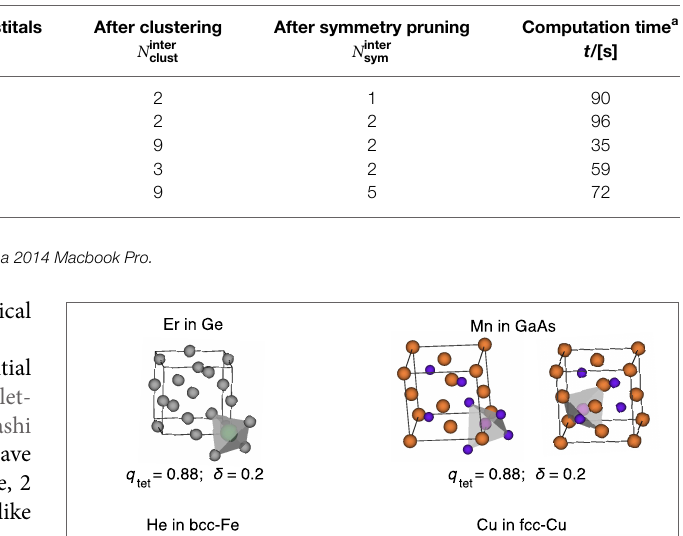
and pattern—(Rong et al., 2015). Since both tetrahedral and octahedral coordination play particularly important roles in pre- dicting ion transport through promising new cathode materials for rechargeable batteries (Rong et al., 2015), we show the use- fulness of the two order parameters q tet and q oct on the exam- ple of magnesium jump-diffusion hops in (empty) spinel man- ganese oxide (mvc-15009). The jump-diffusion path is obtained from a method that Zimmermann, Haranczyk, and co-workers are currently aiming to publish: the potential of electrostatics finite ion size (PfEFIS) method. It reliably estimates migration barriers deduced from nudged-elastic band (NEB; Mills et al. (1995)) calculations on the basis of electrostatic data (estimate SE around 50 meV). For our particular example, the estimate gives 711 meV ( Figure 11 ; black circles and line), which agrees well with the NEB barrier (776 meV; cf., Rong et al. (2015)) while achieving a speed-up factor of 10,000. The diffusion path for Mg in spinel goes from a tetrahedral site over an inter- mediate octahedral site back to a tetrahedral site (Rong et al., 2015). The solid blue line in Figure 11 indicates the change in q tet along the path, whereas the dotted orange line depicts